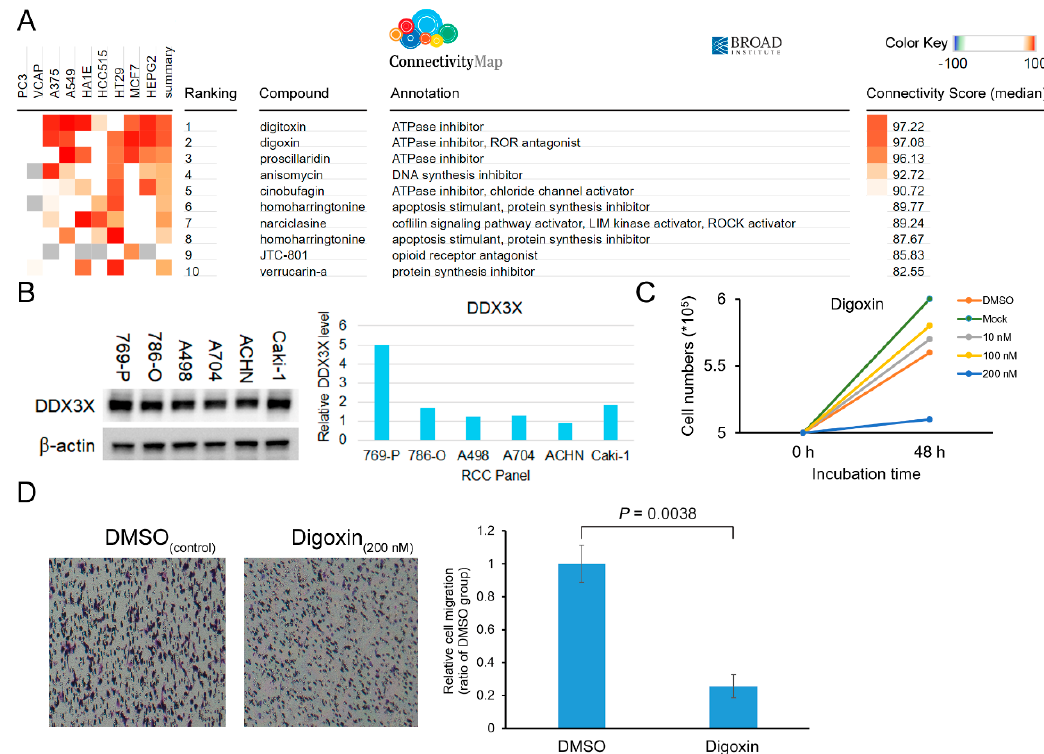
Figure 4. ( A ) The gene signature obtained by the high DDX3X group versus the low DDX3X group was analyzed via the L1000 platform of Connectivity Map. The drugs of the candidate were shown and ranked according to the connectivity score. ( B ) The relative DDX3X expression level was investigated in 7 clear cell subtype RCC cell lines by Western Blot. ( C ) ACHN cell numbers were counted by trypan blue exclusion assay upon 48 h of digoxin treatment. ( D ) ACHN cell migration was evaluated by transwell assay after 48 h of 200 nM digoxin treatment.